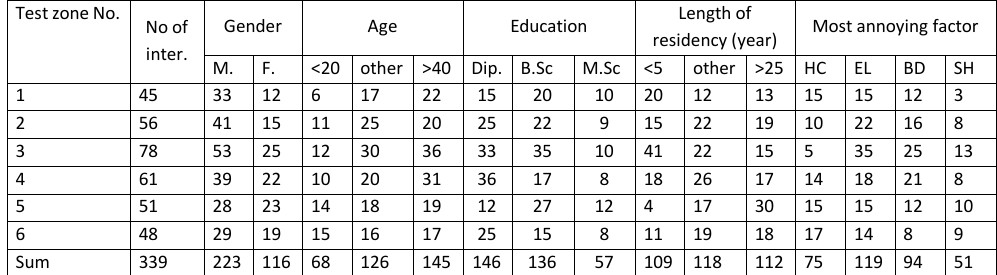
Table 4: Characteristics of the interviewees and their opinions about different types of annoyance. Test zone